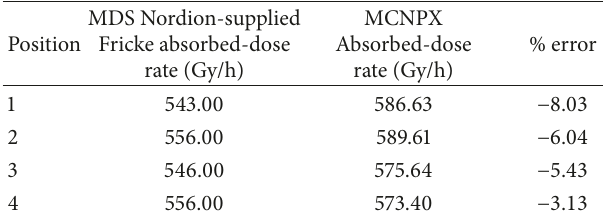
Table 3: Comparison between the values of the doses rates at a distance of 1m from the source centre for each position obtained from simulation and reference